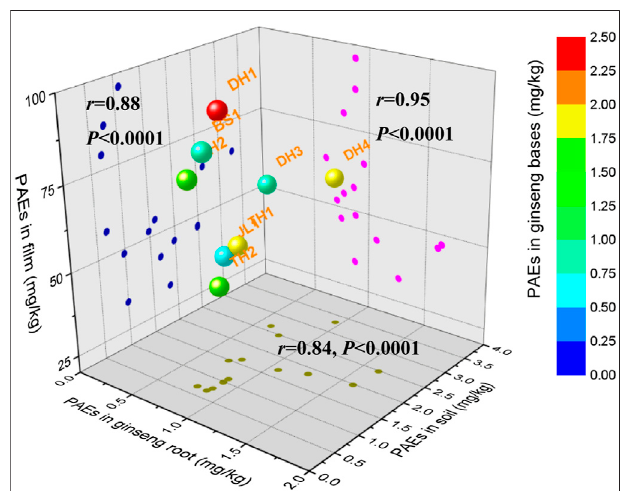
FIGURE 2 | PAEs distributions and correlations among soil, shed fi lm, and ginseng root. The color ballrepresentsthe total concentration